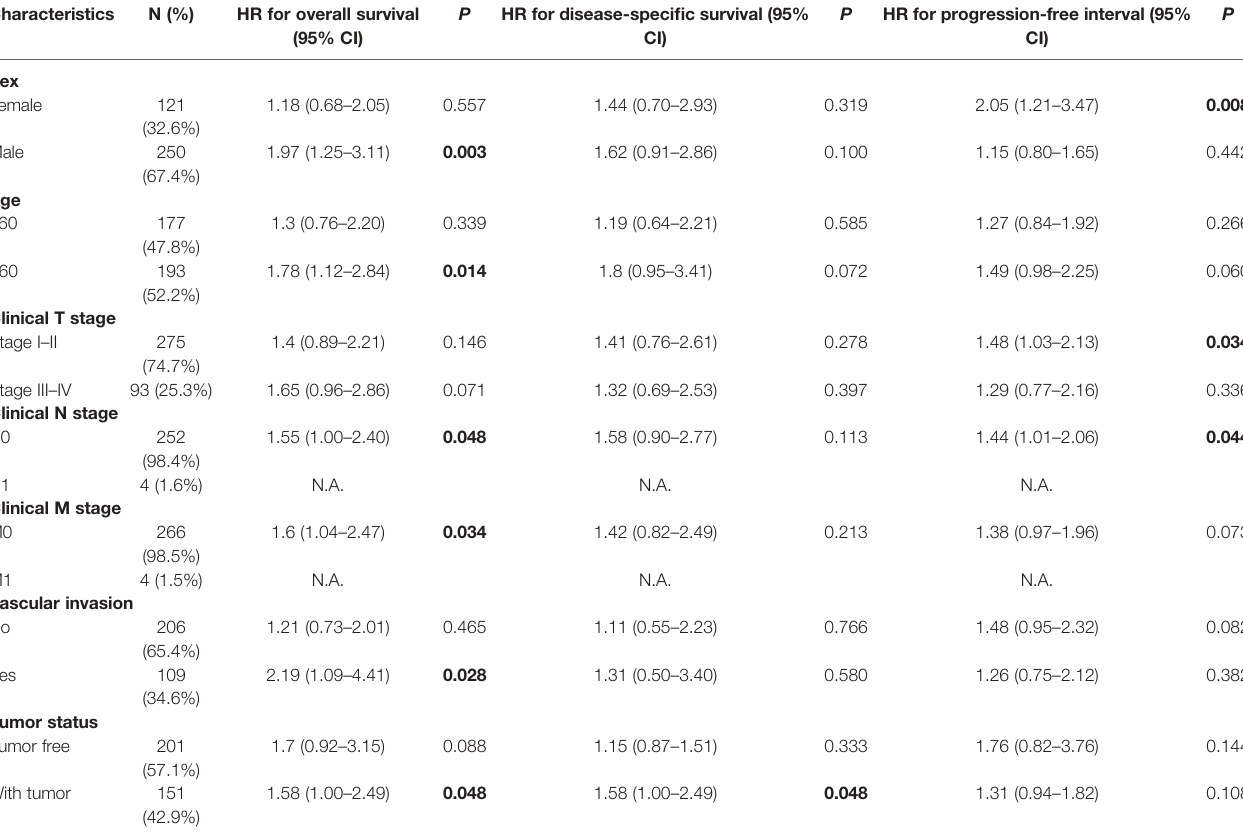
TABLE 3 | Prognostic performance of NDRG1 on clinical prognosis in various liver cancer patient subgroups by Cox regression analysis.